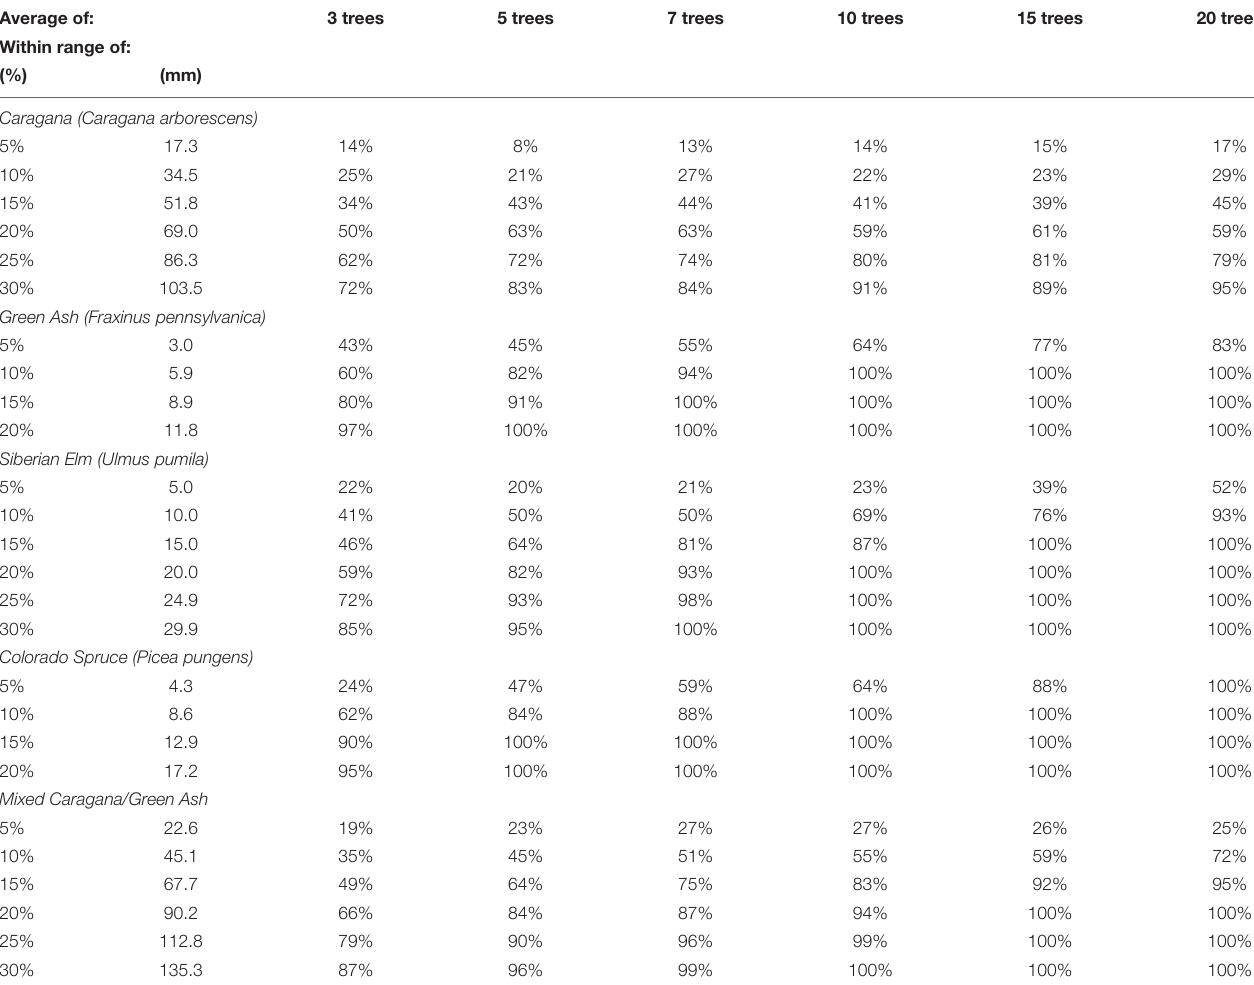
TABLE 5 | Estimating the accuracy of representative measurements of circumference (and derived averages) for different shelterbelt species, using measurements from near Indian Head, SK, Canada. Average